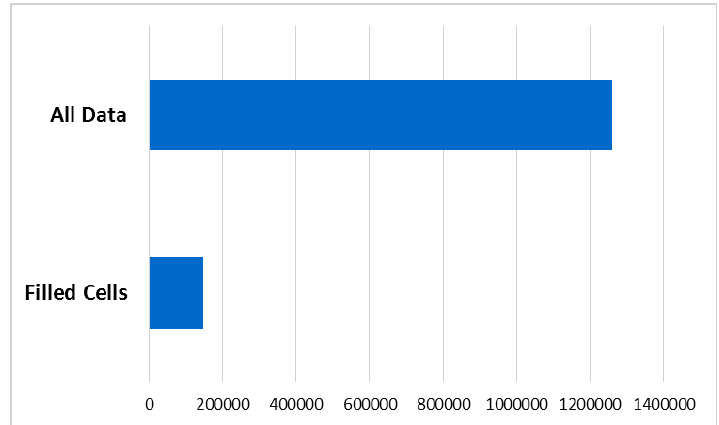
Figure 3 Amount of the Meaningful Data In Comparison With All Possible